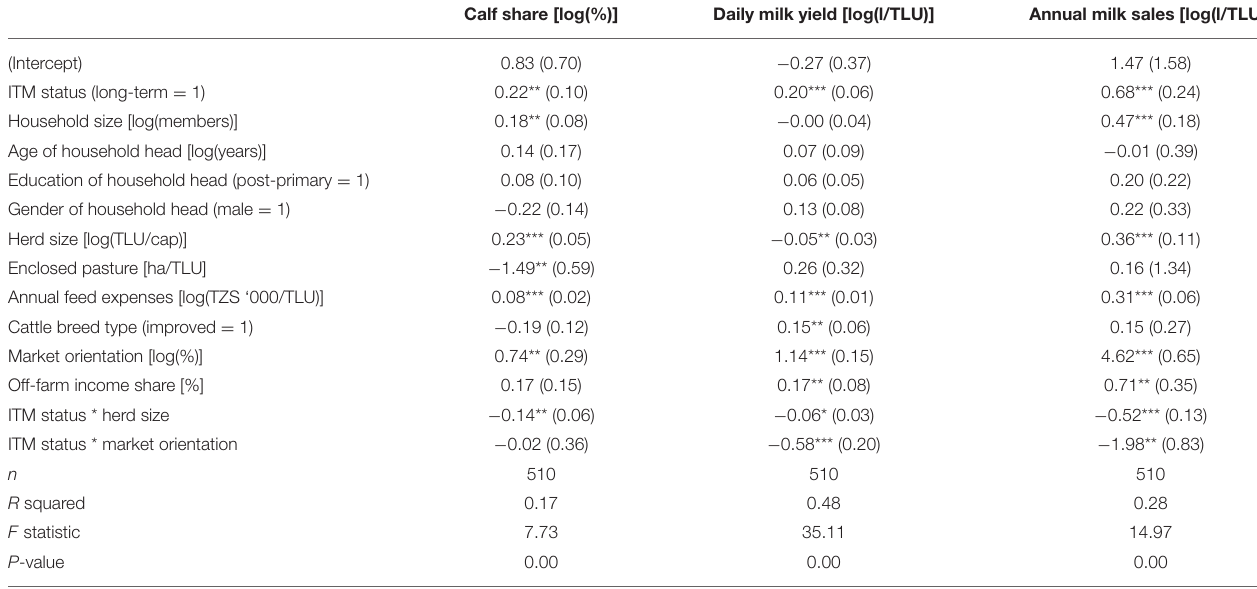
TABLE 4 | ITM vaccination and indicators of herd productivity.